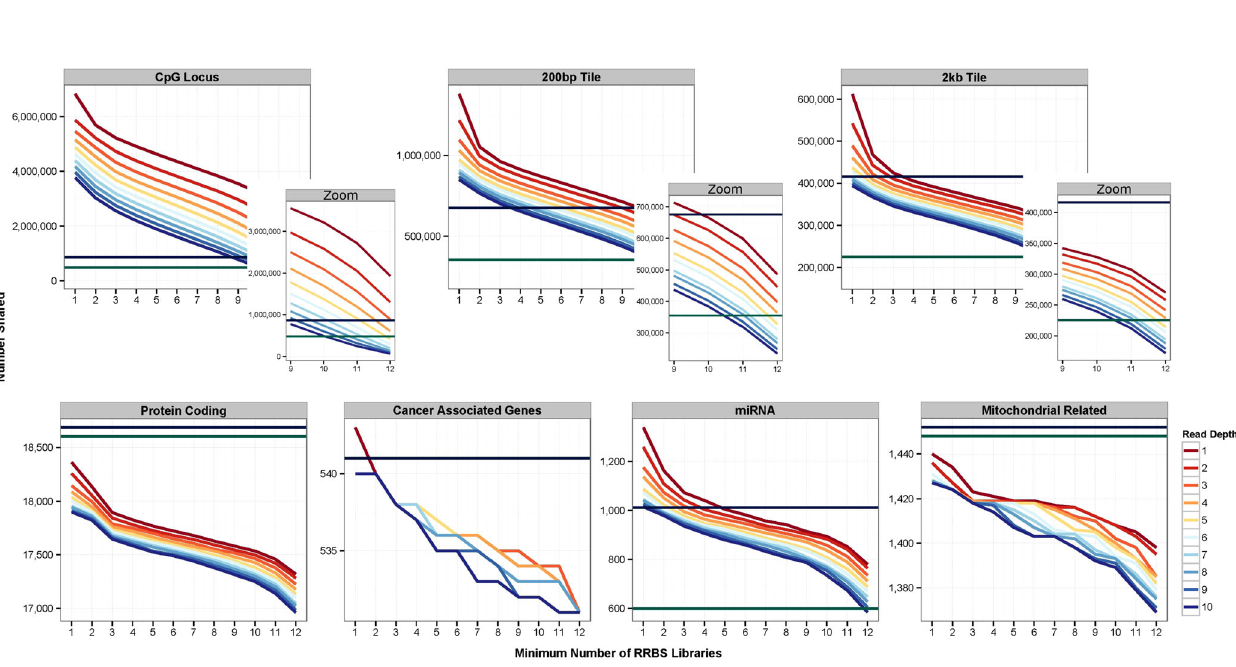
Fig. 3 Overlap in genomic coverage between different rmRRBS libraries. The number of CpG loci, CpG resort context-restricted genomic tiles up to 200 base pairs (200 bp tiles) or 2000 base pairs (2 kb tiles) in length, protein coding genes, cancer-associated genes, microRNA genes, and nuclear encoded genes related to mitochondrial function are plotted relative to the number of rmRRBS libraries in which exact matches overlap. Different color lines correspond rmRRBS read depth, ranging from ≥ 1× to ≥ 10× reads per CpG locus, 200 bp, 2 kb tile, or gene. For reference, horizontal lines indicate the number of CpG loci, tiles or genes covered by the In fi nium HumanMethylation450 (450K; dark green) and the In fi nium MethyationEPIC (850K; dark